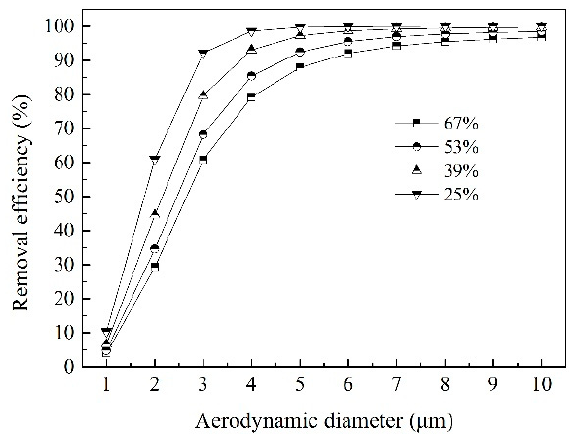
Figure 9. Removal efficiency as a function of particle size at different loads.